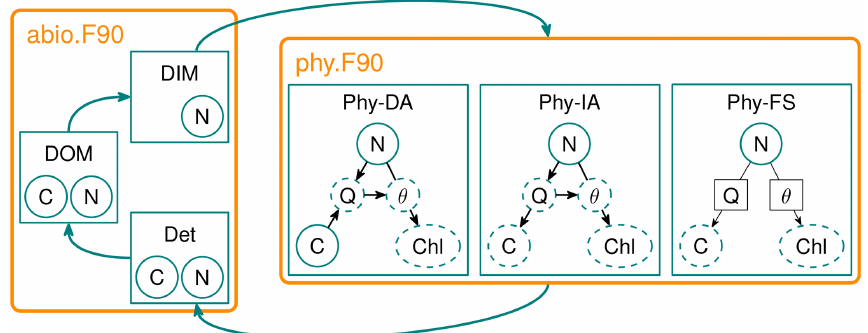
Figure 1. Diagram of the FABM-NflexPD model. Abiotic components, dissolved organic matter (DOM), dissolved inorganic matter (DIM) and Det are calculated by the module abio.F90 , which are then coupled to the phytoplankton simulated by the module phy.F90 that simulates the dynamics of Phy N , Phy C and Phy Chl by the DA, IA and FS variants (see Sect. 2.2.2). Solid circles in the phytoplankton module represent state variables, dashed circles/ellipsoids represent diagnostically calculated variables, and solid squares (for FS) represent prescribed values. The DA variant estimates the N, C and Chl content of phytoplankton based on a resource allocation scheme, whereas the FS variant estimates only N prognostically, while C and Chl are based on prescribed values of nitrogen quota ( Q ) and cellular Chl : C ratio ( θ ) (see the